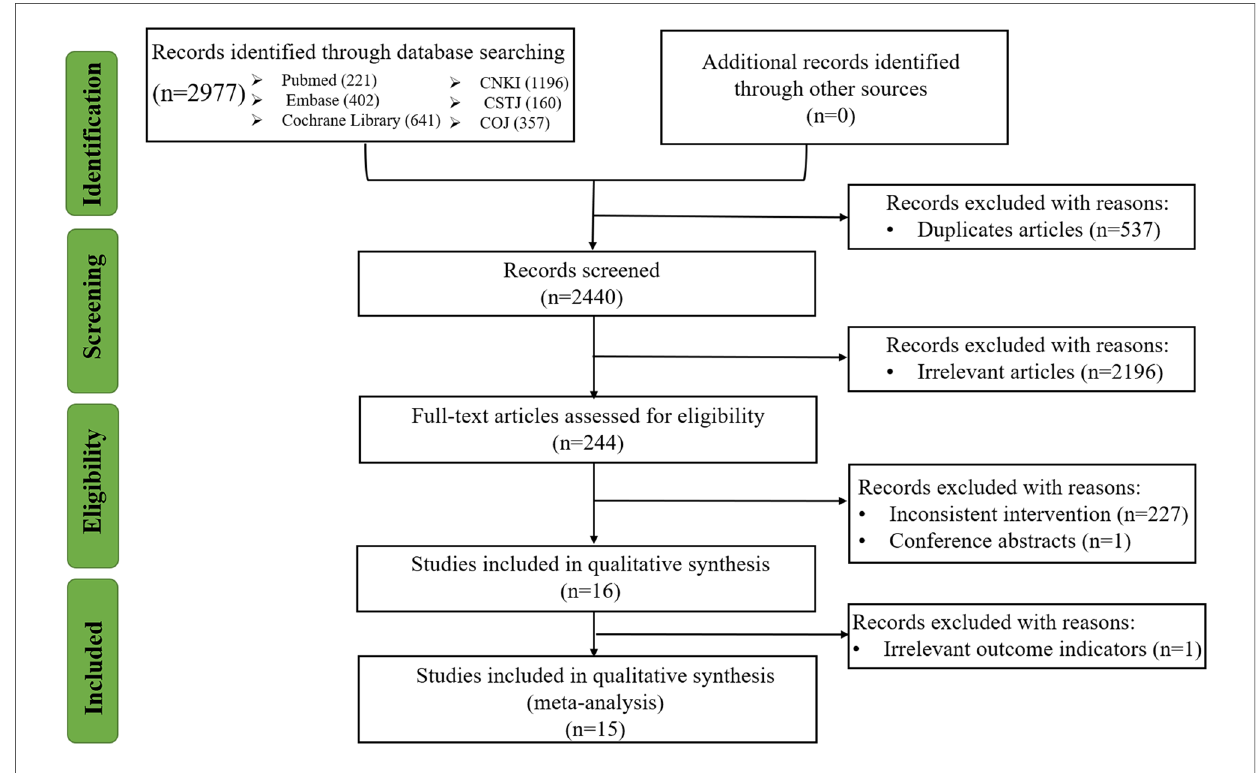
FIGURE 1 Flow chart of study